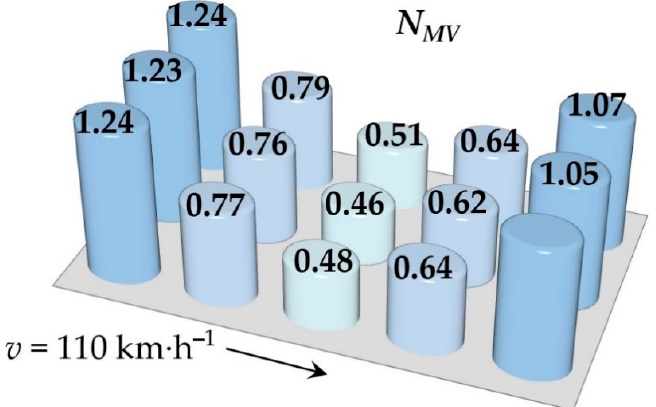
Figure 11. The distribution of the index N MV for a speed of 60 km ∙ h − 1 : the “Modification I” parame- ters.